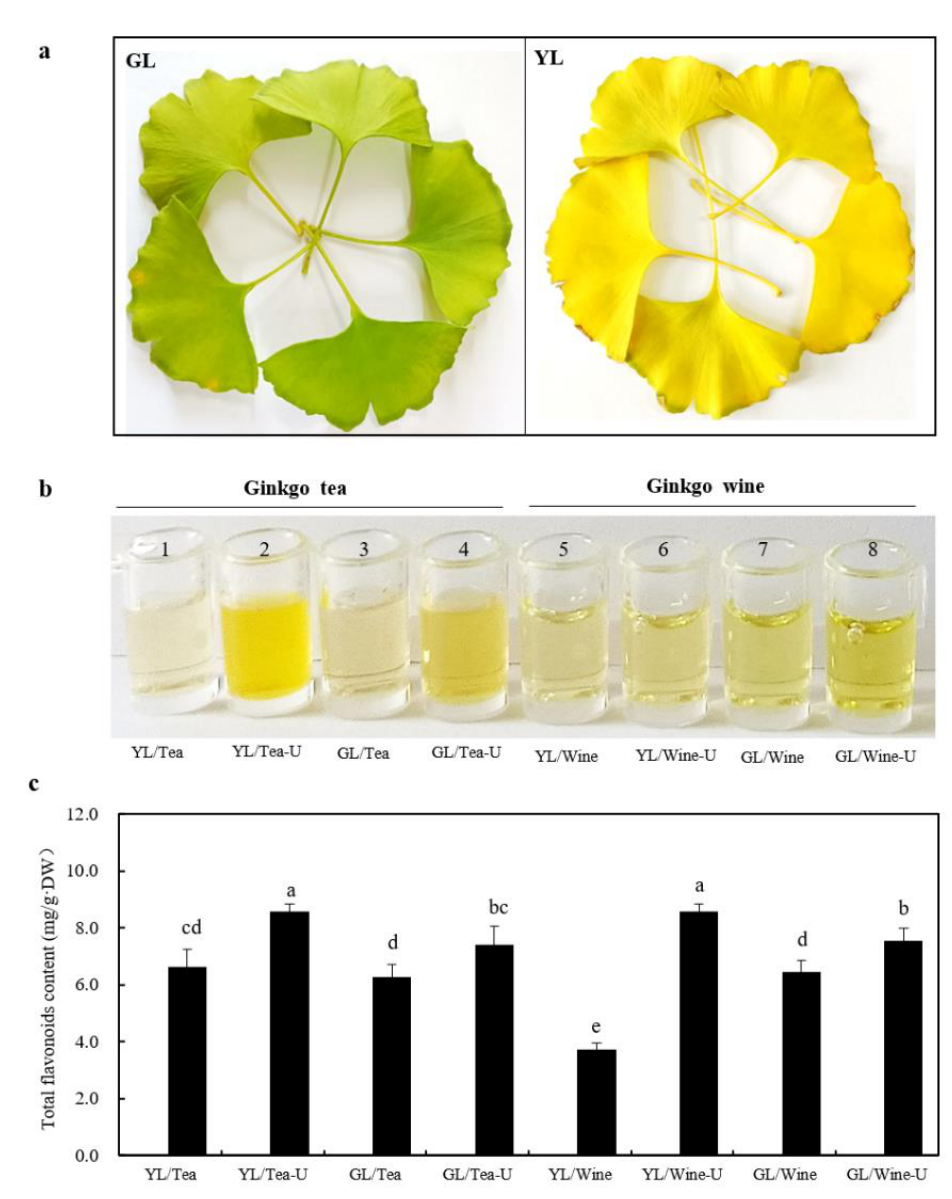
Figure 2. The raw materials, appearance and total flavonoid contents of the ginkgo tea and wine. ( a ) The appearance of the raw materials used for GBE drinks. Green ginkgo leaves (GL) were collected in late October ( Left ) and naturally newly senescent yellow leaves (YL) were collected in early November ( Right ). ( b ) The appearance of the prepared ginkgo tea (numbered 1–4) and ginkgo wine (numbered 5–8) that were derived from the GL and YL powder with or without ultrasound-assisted extraction. ( c ) Total flavonoid contents of ginkgo tea and ginkgo wine made from leaf powder. Rutin was used as the standard, and all the absorption values were obtained at 510 nm. Data are presented as mean ± SD. Different letters represent significantly different values with an alpha value at 0.05, n = 3.